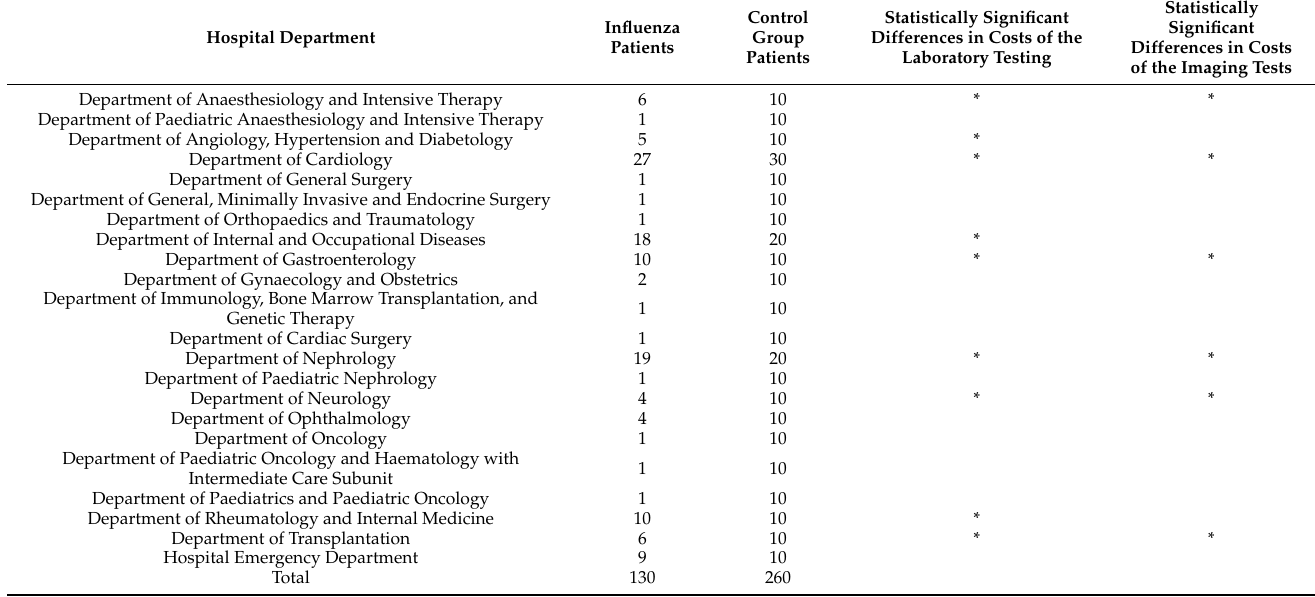
Table 2. Number of influenza and control group patients. The departments with statistically significant differences in their costs for laboratory testing and costs for imaging tests between the groups numerous enough for the statistics to be significant ( p < 0.05) are marked with asterisks